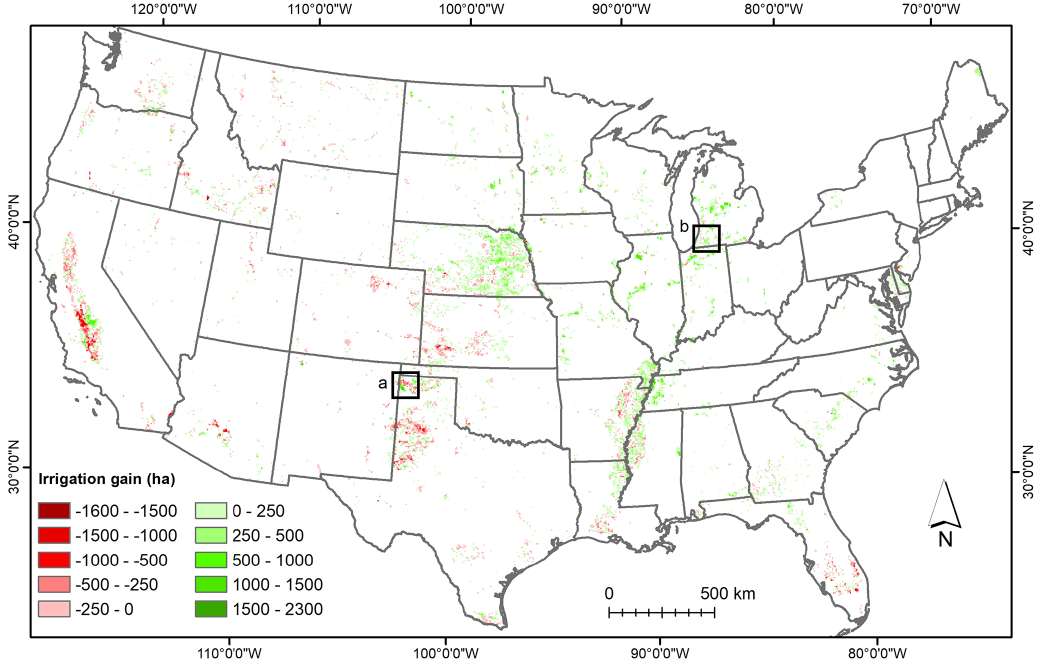
Figure 6. LANID-derived irrigation gain from 1998–2007 to 2008–2017 at the 6km × 6km scale. Per-grid value is calculated as the difference between mean irrigation area of 1998–2007 and that of 2008–2017 (i.e., meanIrArea 2008 − 2017 − meanIrArea 1998 − 2007 , where irArea is LANID-aggregated irrigation area within a 6km × 6km grid). Grids with absolute change < 2 . 5% are shown as